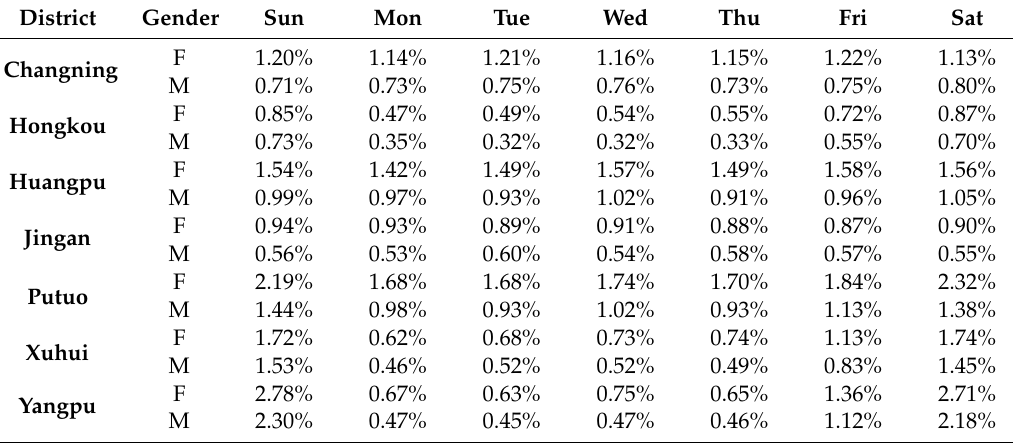
Table 5. Overall